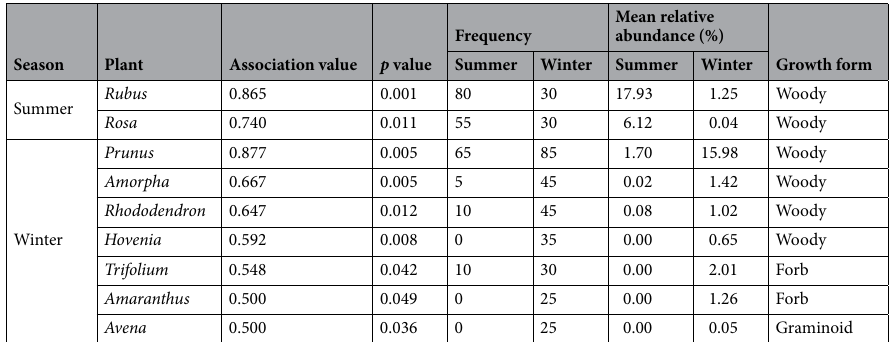
Table 2. Indicator plant genera identified in each season.